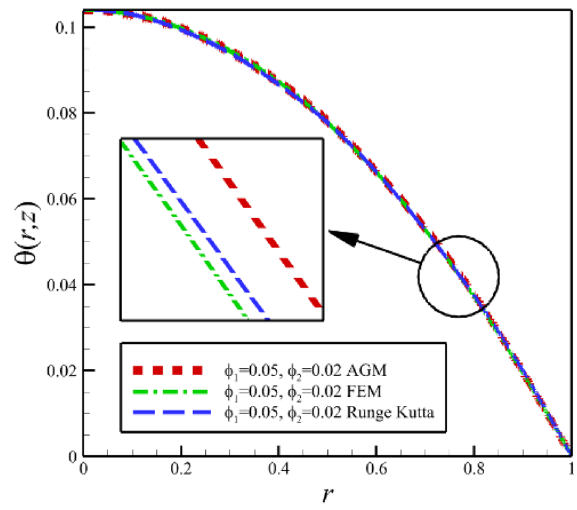
Fig. 6 The result of temperature based on AGM, FEM, and Runge– Kutta with 𝜙 1 =0.01